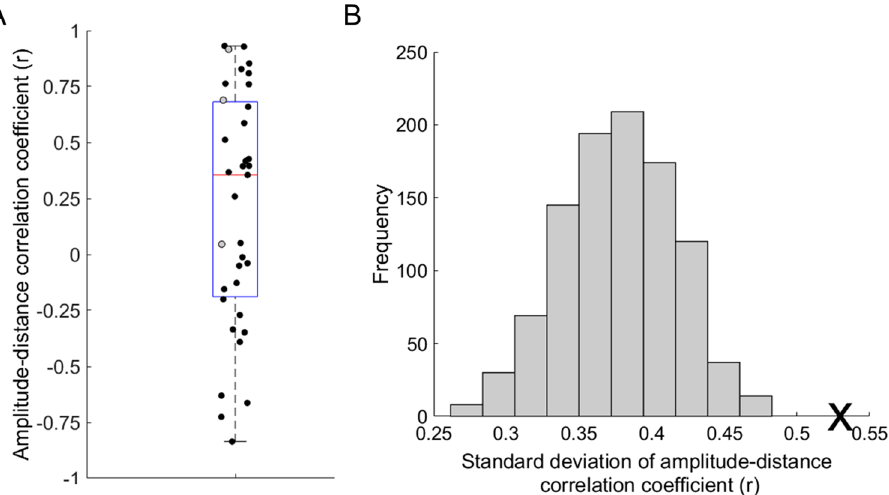
Figure 6. Variability in the visually evoked response of distinct occipitoparietal alpha oscillations to rhythmic flicker relative to IAF. (Panel A ), Boxplot illustrating the significant variability in the amplitude-distance correlation coefficients across the 35 alpha oscillatory components, with the horizontal red line representing the median, and the top and bottom edges of the blue box representing the 75th and 25th percentiles, respectively. Three subjects showed only one source (plotted as grey circles), the remaining ten subjects showed multiple sources distributed across the three possible amplitude-distance correlation coefficient variations (plotted as black circles). (Panel B ), A histogram, illustrating the distribution of randomly acquirable standard deviations in amplitude-distance correlation coefficients estimated from a permutation test across all 35 alpha oscillators, which showed that our observed standard deviation value of 0.527 (marked by a black cross) lies well outside of the range of standard deviation values likely to occur by chance (permuted mean standard deviation = 0.3773, shown in grey bars) retrieved from 1,000 permutations, p =